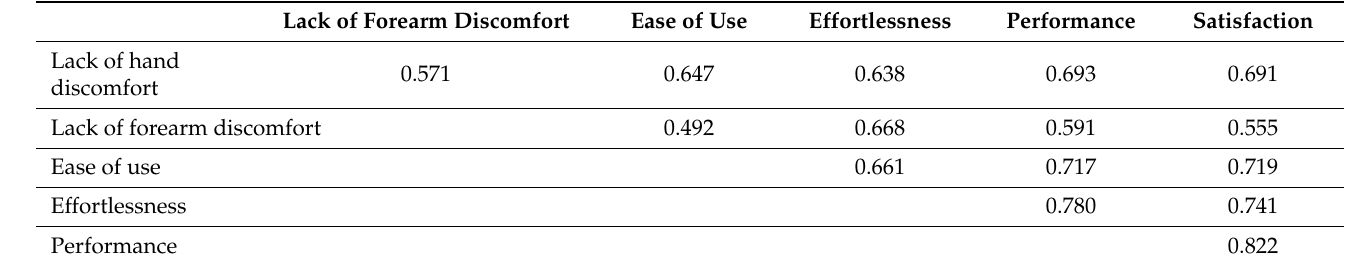
Table 5. Pearson correlation factors ( p < 0.001) for the subjective ratings (N = 37).